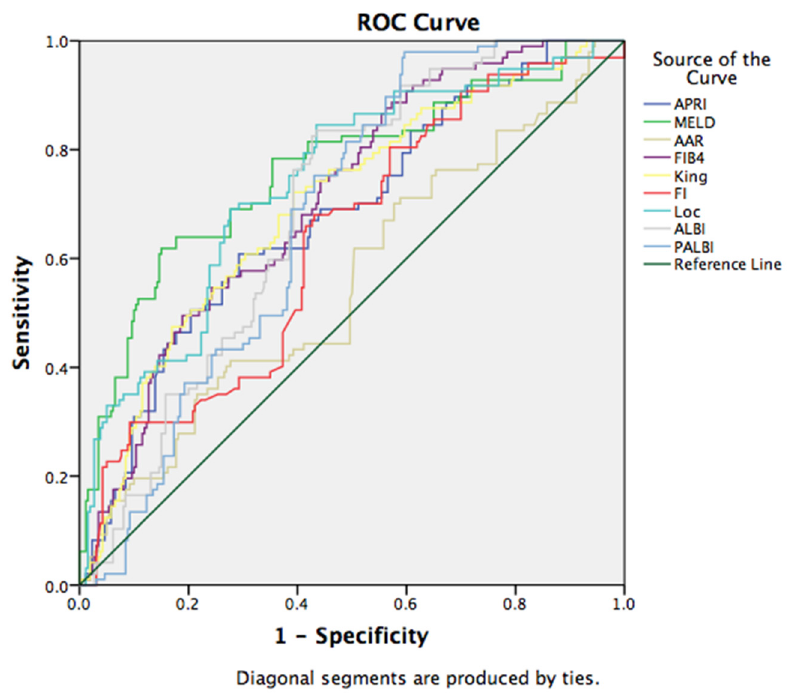
Figure 3. ROC curve for the discriminative ability of the prognostic scores to detect short-term mor- tality.